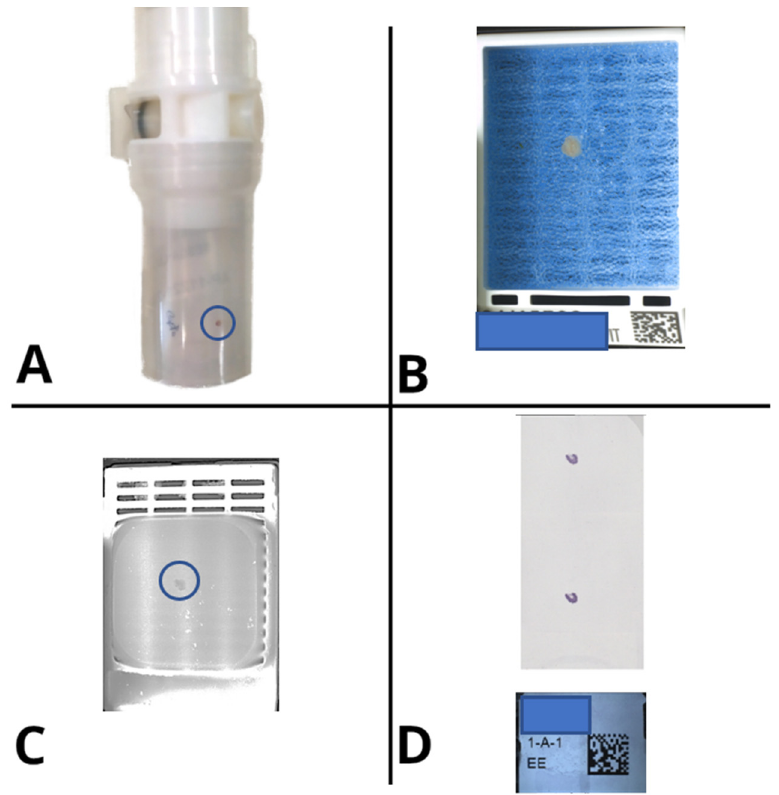
Figure 4. Digital pictures taken at each step of the life of the specimen and respective cassettes fully document the flow of tissue in the lab, allowing global traceability and high-resolution error tracking. ( A ) Specimen container as it is received; ( B ) Cassette at grossing, before closing its lid; ( C ) Surface of the FFPE block after microtome sectioning; ( D ) Macro picture of the glass slide after staining.